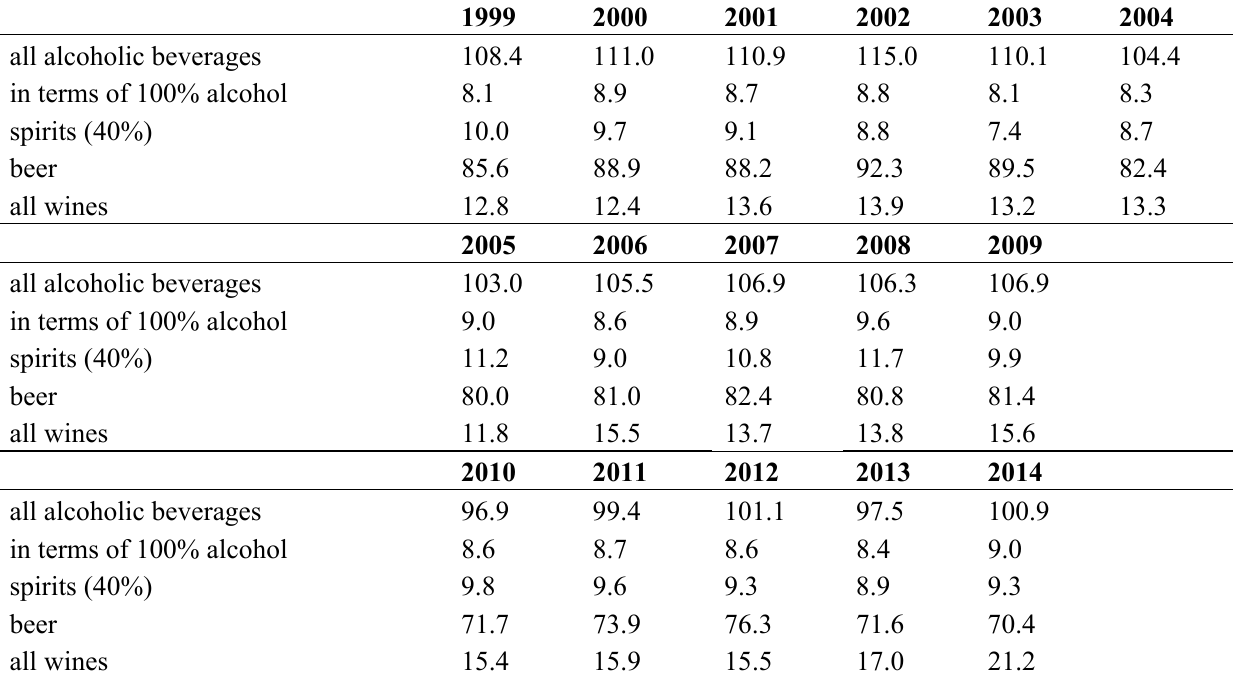
Table 4. The structure of alcohol consumption in liters per head in Slovakia from 1999 to